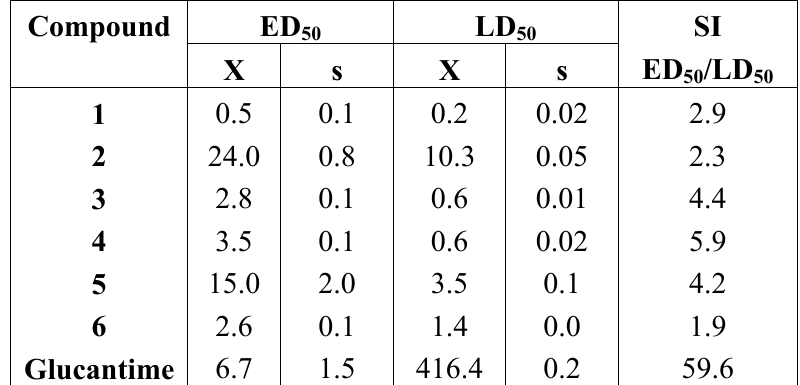
Table 1. In vitro activity of